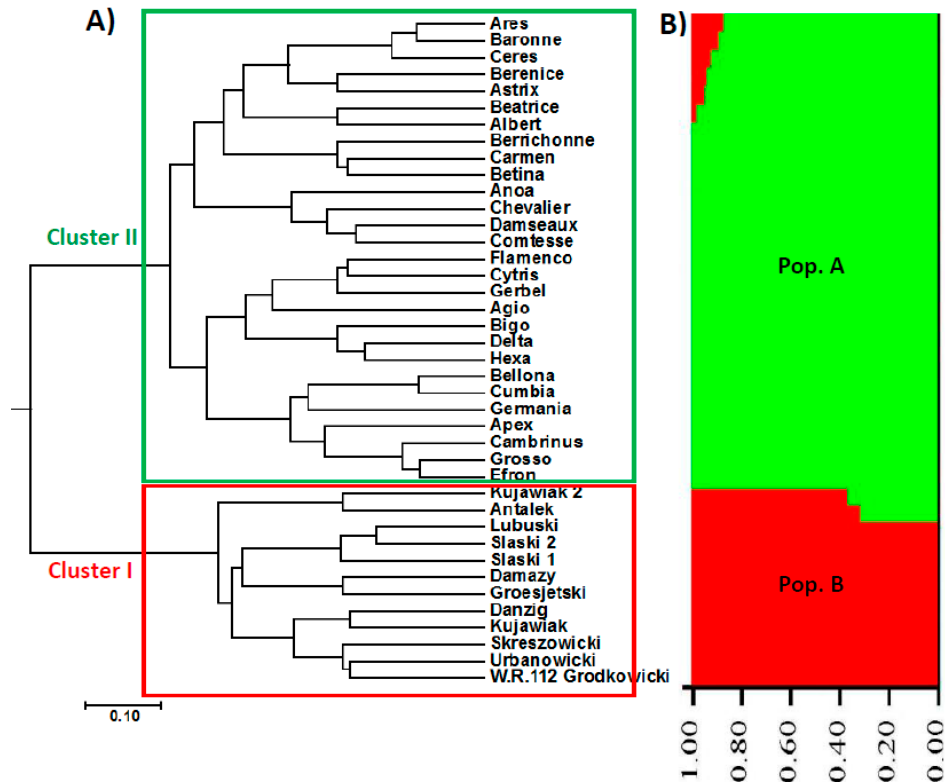
Figure 1. UPGMA phylogenetic tree and population structure (at K = 2) of the 40 barley accessions based on AFLP data; ( A ) Cluster I included the Eastern European genotypes (Poland), while Cluster II represents the Western European genotypes (France and the Netherlands). ( B ) Structure analysis showing that the 40 barely accessions are assigned to two populations (Pop. A represented in green comprised the Western European genotypes, while Pop. B represented in red included the Eastern European genotypes).